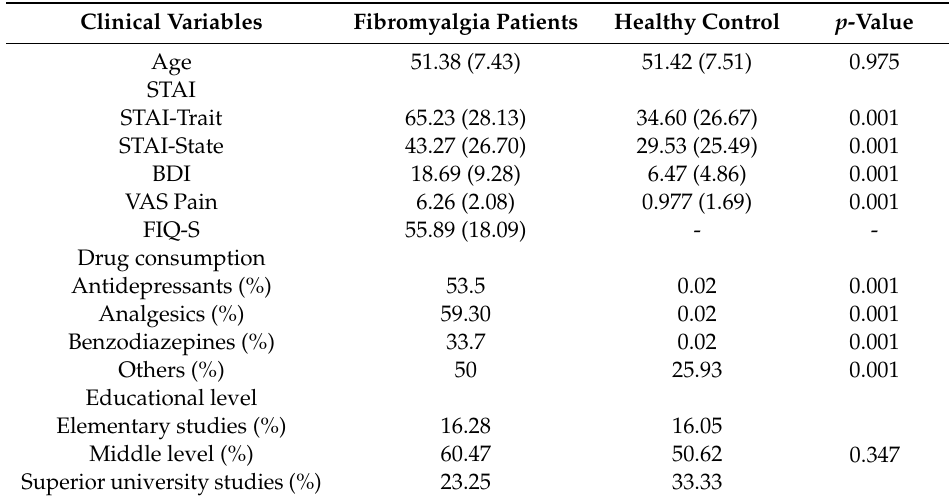
Table 1. Means and standard deviations of age, levels of trait and state anxiety, depression, pain, drug consumption and educational levels for each group of participants. p -values for each statistical contrast are also